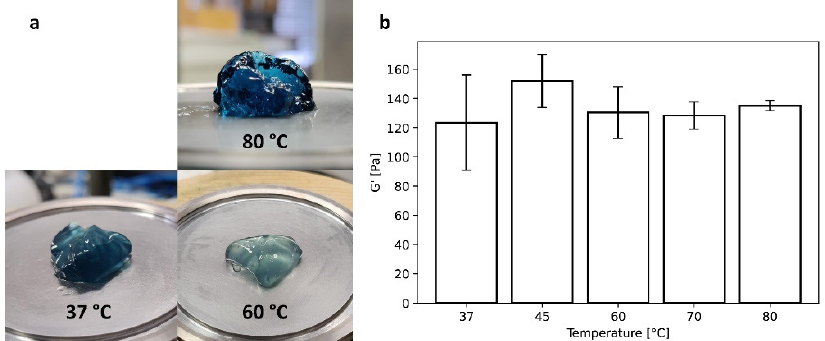
Figure 4. Effects of gelling temperature on chitosan–genipin-based hydrogels (polymer concentra- tion = 1%, RD/G = 90): ( a ) photographs of the genipin-based hydrogels obtained at different temper- atures; ( b ) dependence of the storage modulus ( G ′ ) recorded at 1 Pa from temperature for genipin- based chitosan hydrogels. No significant difference was found in the storage modulus of the differ- ent gels.